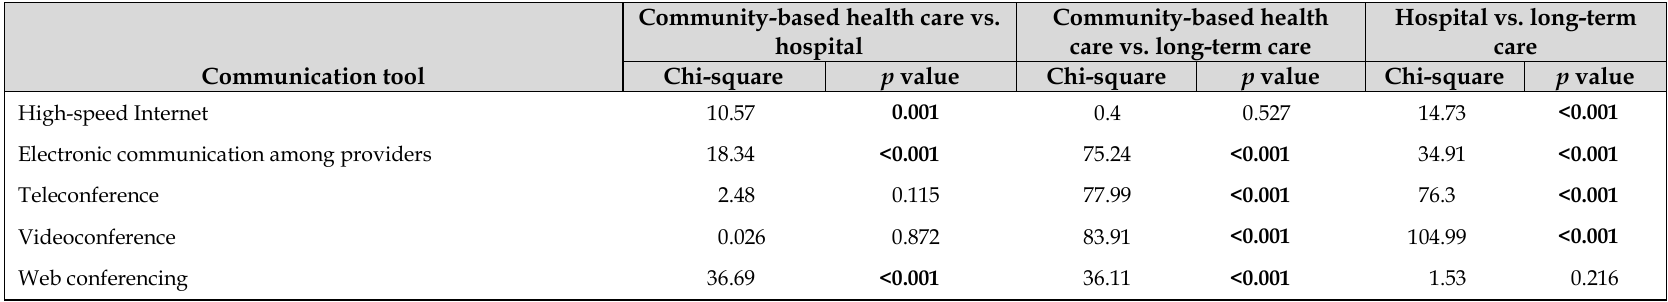
Table 3 Direct access to communication tools, by practice